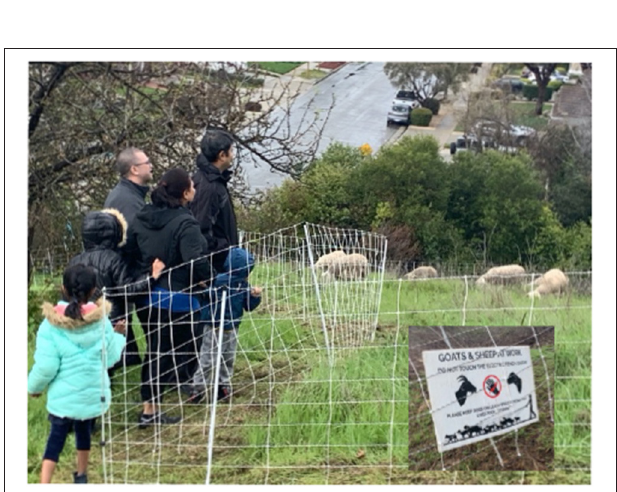
FIGURE 12 | Targeted grazing for fuels reduction using sheep in a suburban park in San Jose, California. Photo: S. Barry.